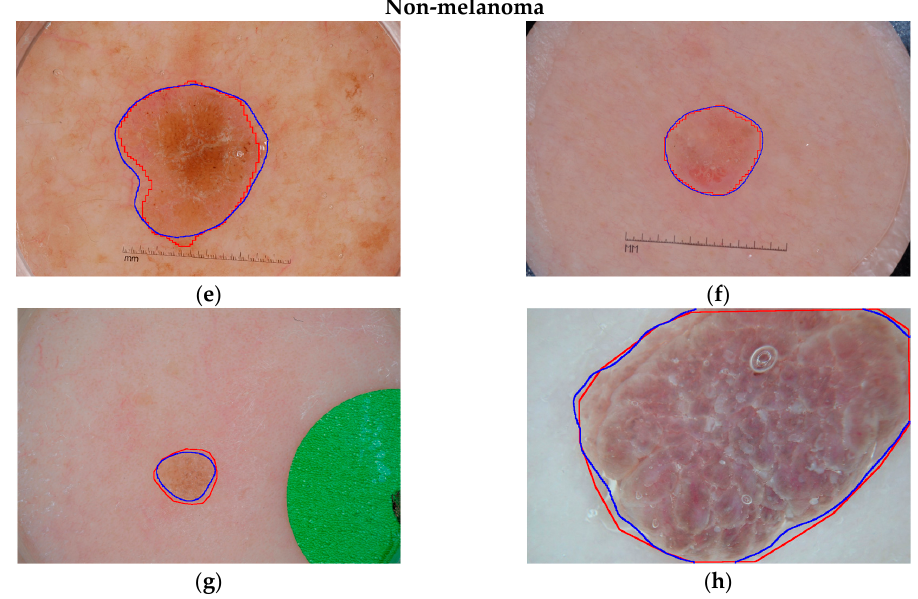
Figure 8. Examples of skin lesion segmentation results produced by LIN for ISIC 2017 validation set. ( a – d ) are the results of Melanoma, while ( e – h ) are the results for Seborrheic keratosis and Nevus. The blue and red lines represent the segmentation results and ground truths.